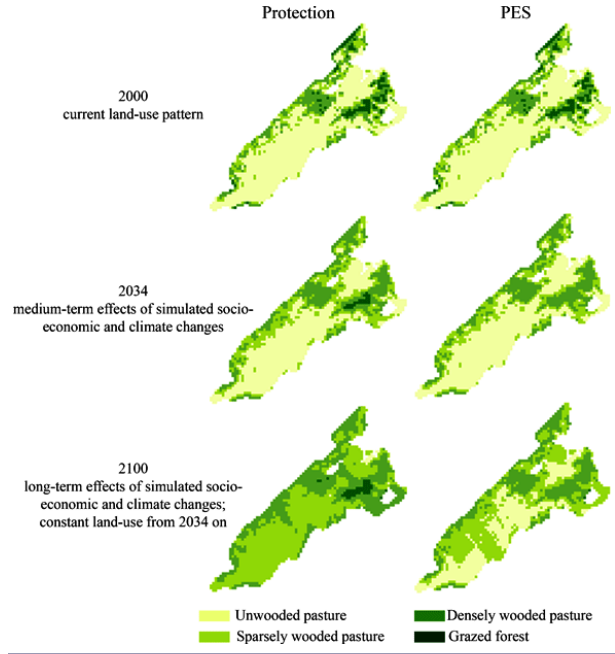
Fig. 2 . Landscape: structural change in Les Planets-Cluds (1200 m a.s.l., intensive use) with the protection and payment for environmental services (PES) policy scenarios.